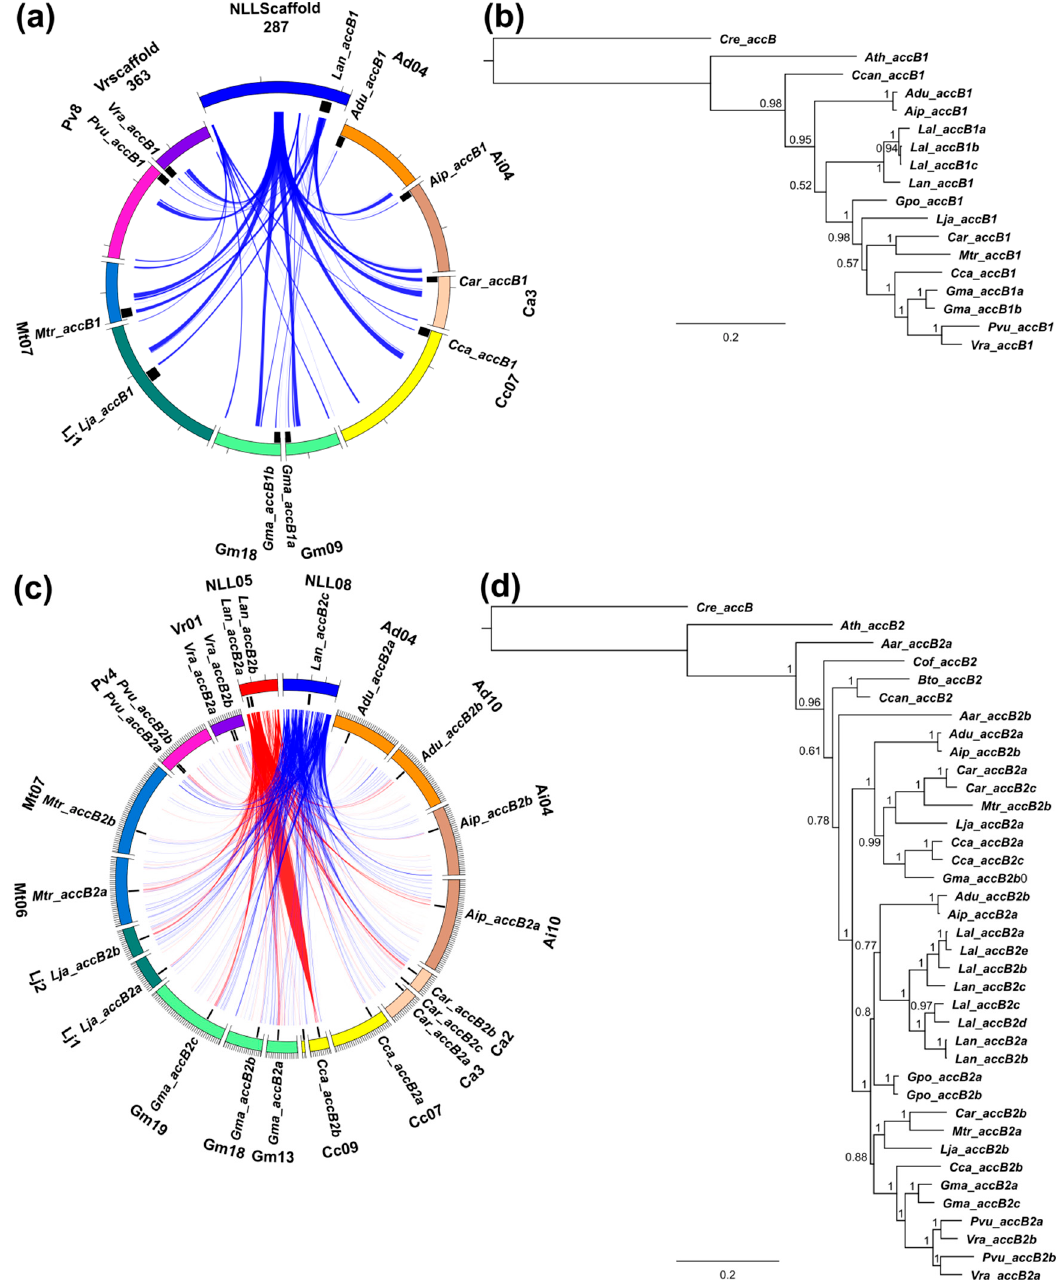
Figure 7. Comparative mapping and phylogenetic inference of legume biotin carboxyl carrier protein ( accB ) subunit genes of plastid ACCase. ( a , c ) syntenic patterns revealed for narrow-leafed lupin genome regions and corresponding regions of legume chromosomes. Abbreviated species names are provided as follows: Aar, Acacia argyrophylla ; Adu, Arachis duranensis ; Aip, A. ipaensis ; Ath, Arabidopsis thaliana ; Bto, Bauhinia tomentosa ; Car, Cicer arietinum ; Cca, Cajanus cajan ; Ccan, Cercis canadensis ; Cof, Copaifera officinalis ; Cre, Chlamydomonas reinhardtii ; Gma, Glycine max ; Gpo, Gompholobium polymorphum ; Lal, Lupinus albus ; Lan, L. angustifolius ; Lja, Lotus japonicus ; Mtr, Medicago truncatula ; Pvu, Phaseolus vulgaris ; Vra, Vigna radiata . ACCase gene loci are indicated by black bars. Ribbons visualize homologous links identified by DNA sequence alignments. L. angustifolius genomic sequences and homology links are marked by colors: red and blue. ( b , d ) majority rule consensus trees found in a Bayesian analysis of legume accB1 and accB2 genes. Numbers are posterior probabilities. The lengths of MAFFT alignments were 933 nt and 1014 nt.